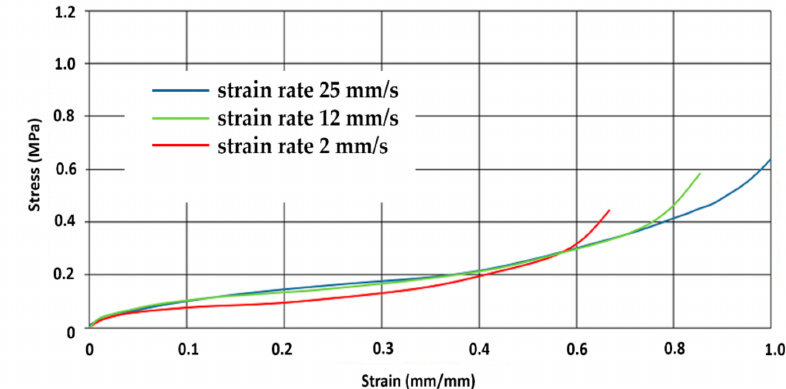
Figure 13. The stress–strain curves of EPP foam (density 20 g/dm 3 ) at a quasistatic loading, different strain rate.